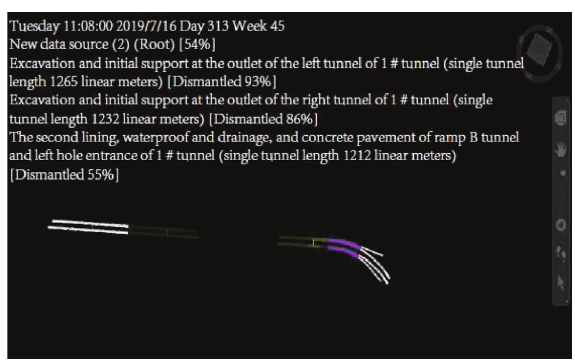
Figure 9: Four-dimensional construction schedule simulation process.